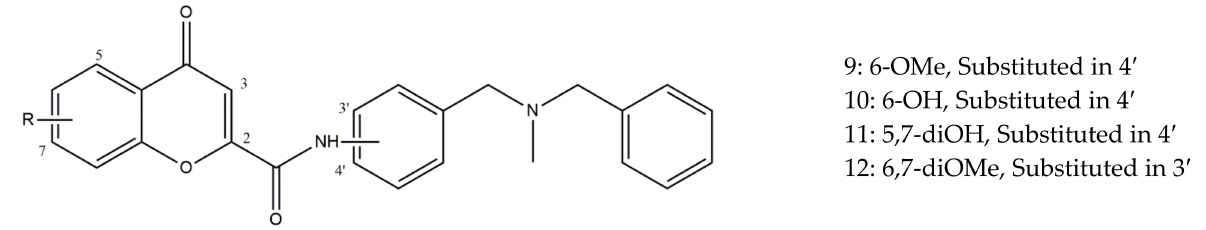
Figure 7. General structure of 4-chromenone- N,N -dibenzyl- N -methylamine (DBMA)